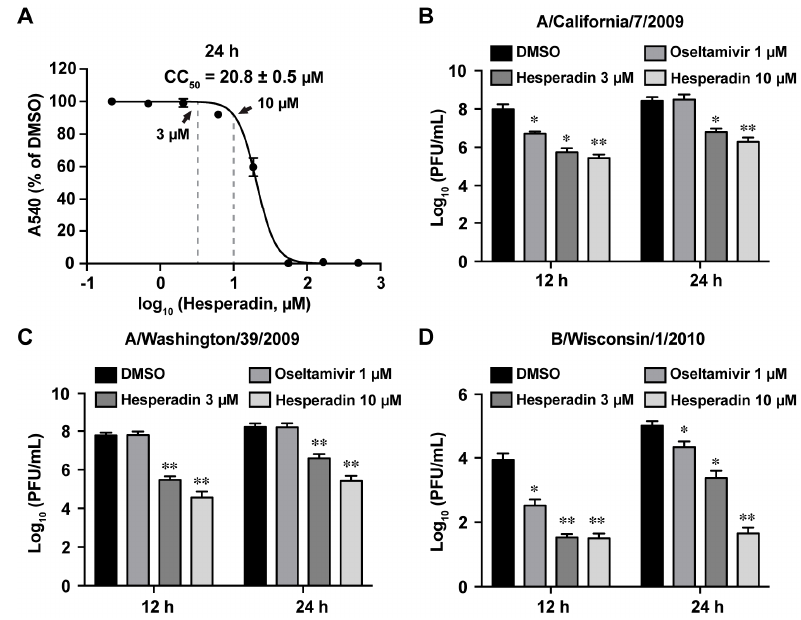
Figure 3. Antiviral activity of hesperadin against A/California/07/2009 (H1N1), A/Washington/39/2009 (H1N1) and B/Wisconsin/1/2010 (Yamagata) at a high multiplicity of infection (MOI) of 1. ( A ) CC 50 of hesperadin with a 24 h incubation time in MDCK cells. The concentrations at 3 and 10 µM are indicated by arrows; the CC50 value represents the average of eight repeats ± standard deviation; MDCK cells were infected with A/California/7/2009 (H1N1) ( B ) A/Washington/39/2009 (H1N1) ( C ), or B/Wisconsin/1/2010 ( D ) at a MOI of 1, 3 or 10 µM of hesperadin was added after viral infection. Viruses from supernatant were harvested at 12 or 24 h p.i. Virus titers were determined by plaque assay as previously described [27]. 1 µ M of oseltamivir carboxylate was included as a control. Asterisks indicate statistically significant difference in comparison with the DMSO control (student’s t -test, * p < 0.05, ** p < 0.01). The results represent the average of two repeats ± standard